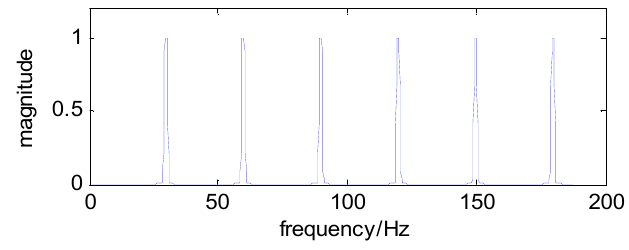
Figure 3. The frequency-domain plot of a comblet filter with =6 comb